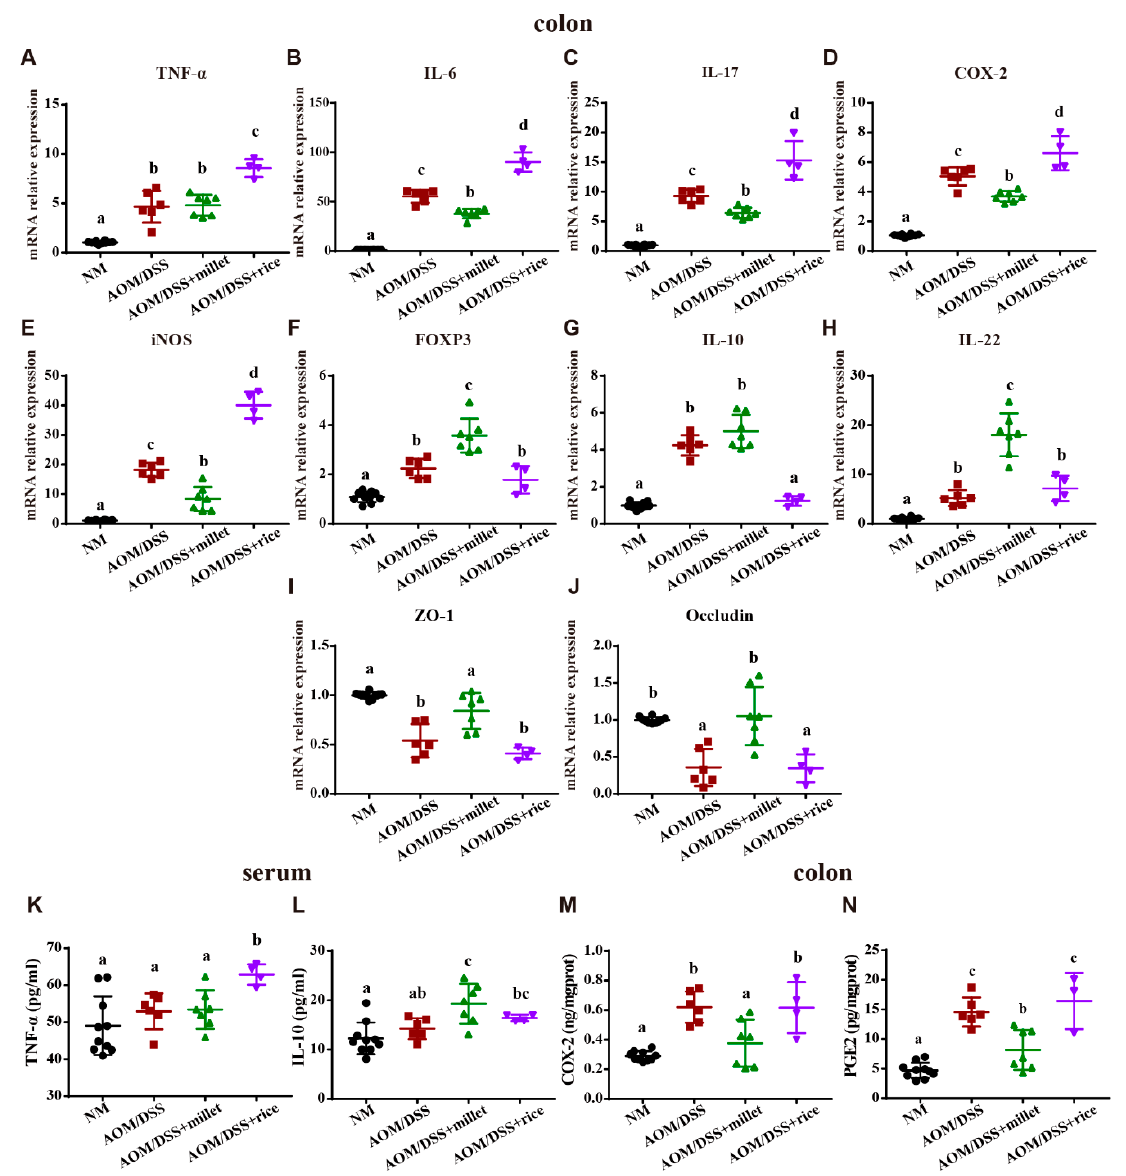
Figure 4. The mRNA expression levels of ( A ) TNF- α , ( B ) IL-6, ( C ) IL-17, ( D ) COX-2, ( E ) iNOS, ( F ) FOXP3, ( G ) IL-10, ( H ) IL-22, ( I ) ZO-1, and ( J ) occludin in the colonic samples. The expression levels of ( K ) TNF- α and ( L ) IL-10 in serum. The expression levels of ( M ) COX-2 and ( N ) PGE2 in the colon. Data are shown as the mean ± SD. Means with different letters are significantly different ( p < 0.05). n = 10, 6, 7, and 4 for NM, AOM/DSS, AOM/DSS + millet, and AOM/DSS + rice groups, respectively. These RT-qPCR findings were further confirmed via ELISA. There was no significant di ff erence in the concentration of serum TNF- α among the NM, AOM / DSS and AOM / DSS + millet groups. However, compared to levels in the AOM / DSS + millet group, the intake of rice significantly enhanced the concentration of serum TNF- α . The concentration of anti-inflammatory cytokine IL-10 in the serum was significantly increased by millet treatment compared to that in the AOM / DSS group. Moreover, the concentrations of the pro-inflammatory cytokines COX-2 and PGE2 in colon tissues were significantly upregulated by AOM / DSS treatment. The dietary intervention of millet significantly reduced the levels of colonic COX-2 and PGE2 compared to the levels for the AOM / DSS- and AOM / DSS + rice-treated